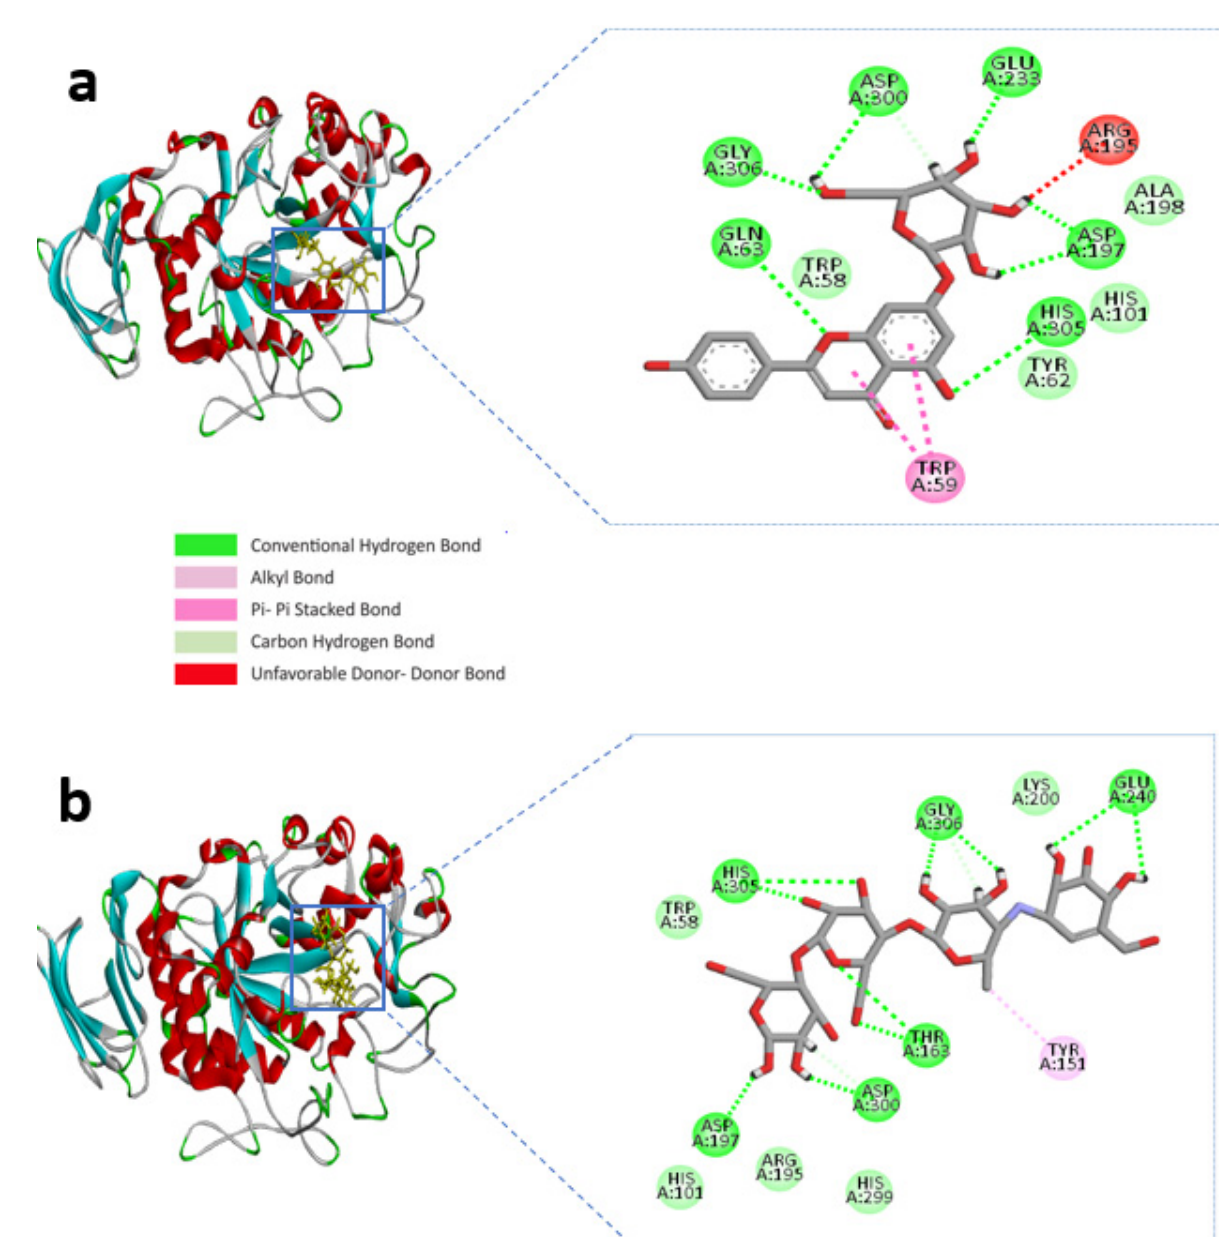
all residues except ASP-60, ASN-258 generated double hydrogen bonds with the